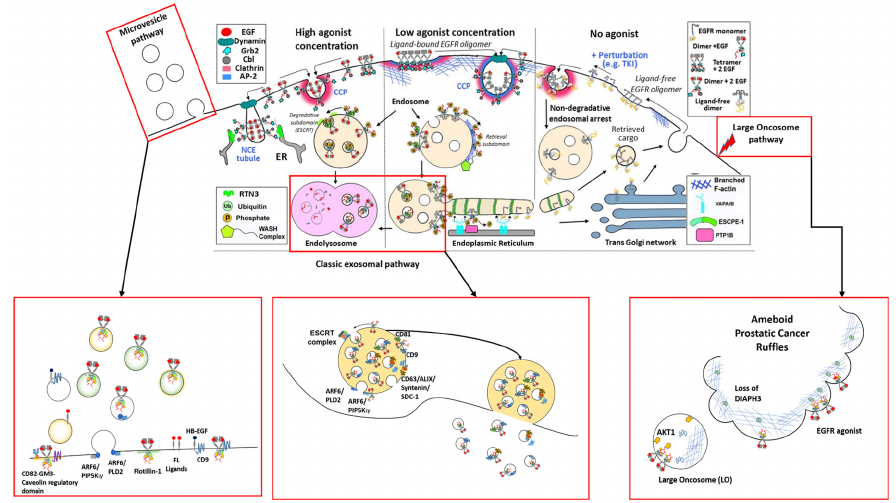
Figure 2. An EGFR-centric view of EV biogenesis. This cartoon describes the possible routes taken by EGFR in its journey through and out of the cell. Top panel: degradative pathway at high EGF dose (left), retrieval at low dose (middle), and recycling (right). Endoplasmic reticulum (ER) contacts with tubular buds, which lead to EGFR dephosphorylation by PTPB1, are also shown. Possible EGFR structures and relevant endocytic effectors are depicted in each location. Red frames highlight the different known pathways of EV biogenesis involving EGFR and its ligands, namely the ARF6-linked microvesicle pathway at the plasma membrane (bottom left), the classical exosome pathway involving sorting at the MVB (bottom middle) and the cancer-specific Large Oncosome pathway (bottom right).